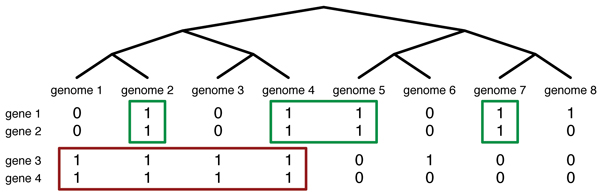
Phylogenetic profiles. We show hypothetical phylogenetic profiles for four genes. Genes 1 and 2 have four common 1's ("matches") in three runs while genes 3 and 4 have four matches in a single run. We hypothesize that genes 1 and 2 are more likely to be truly co-evolving while genes 3 and 4 are likely to be just lineage-specific.